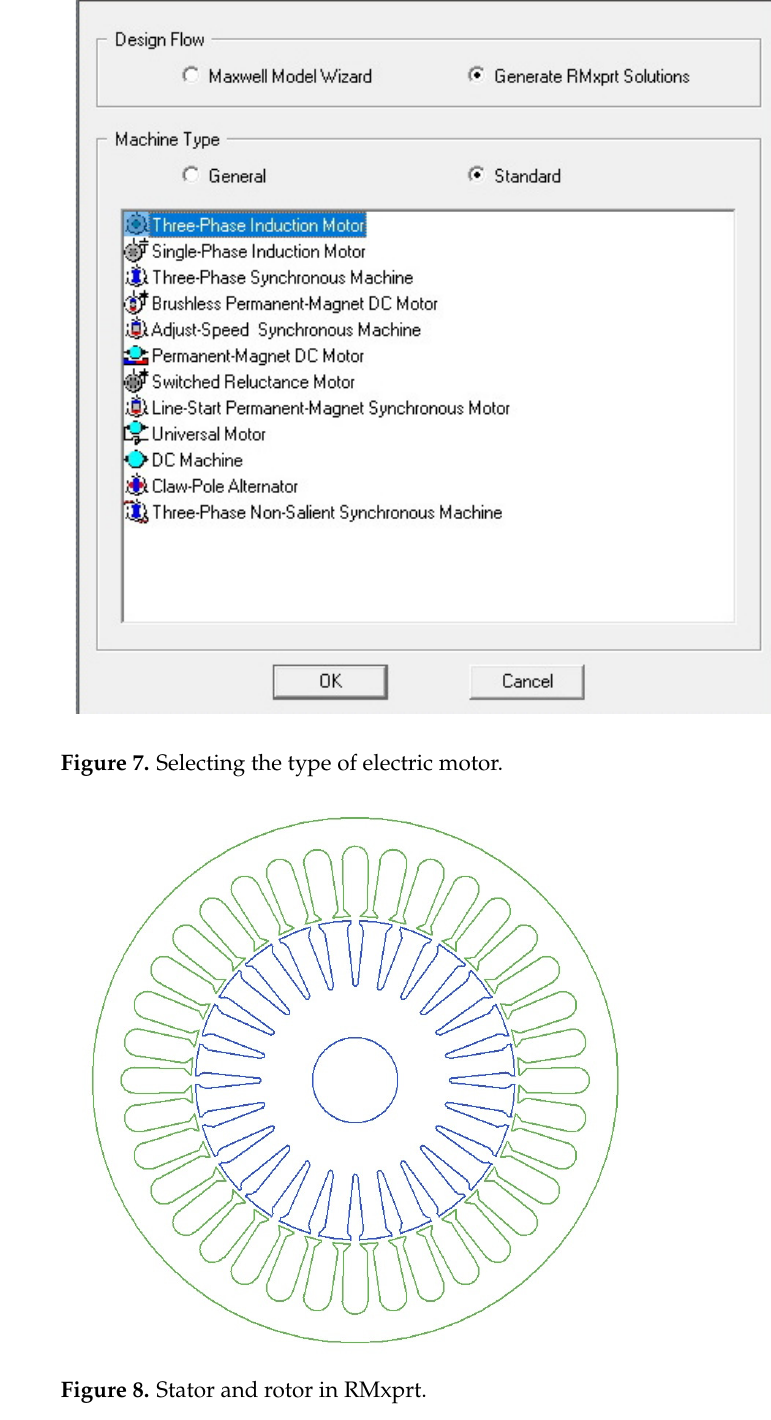
Figure 9. End connections in stator winding. Following the completion of the RMxprt forms, the project will be prepared for com- putation. A new solution profile will be generated, and solution parameters, such as var- ious load types (e.g., constant speed, power, torque, and fan load), will be entered [31]. Figure 10 presents the Solution Profile window.